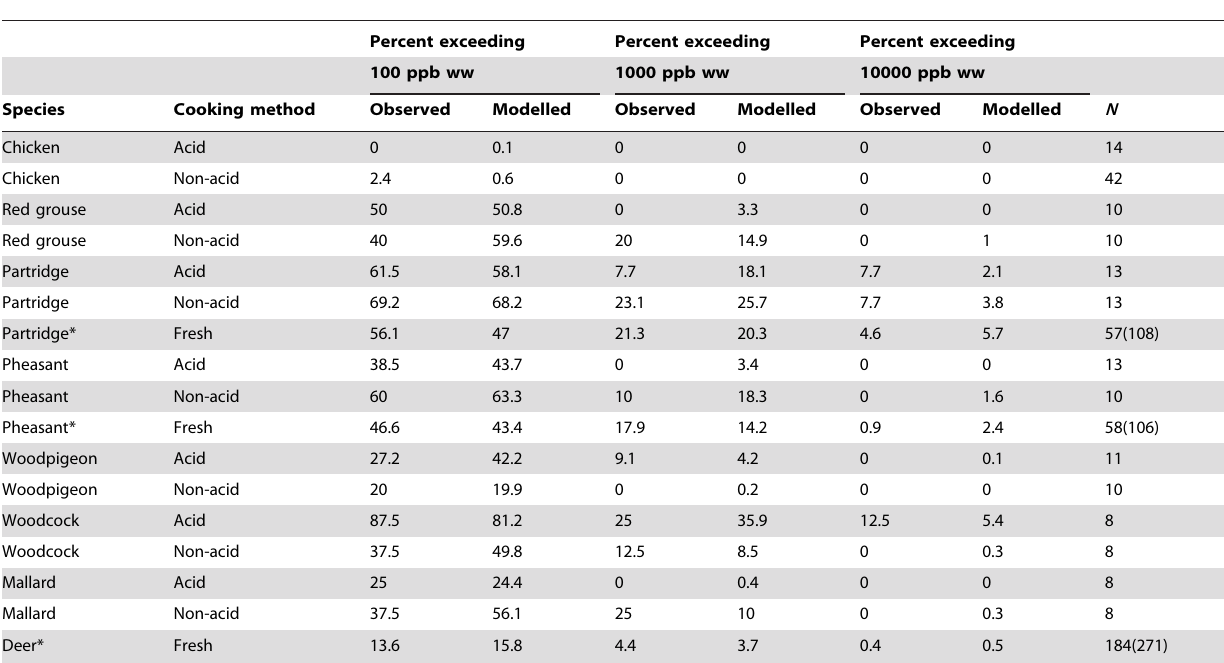
Table 3. Percentages of samples of game and chicken that exceeded each of three threshold values of lead concentration (100, 1000 and 10000 ppb wet